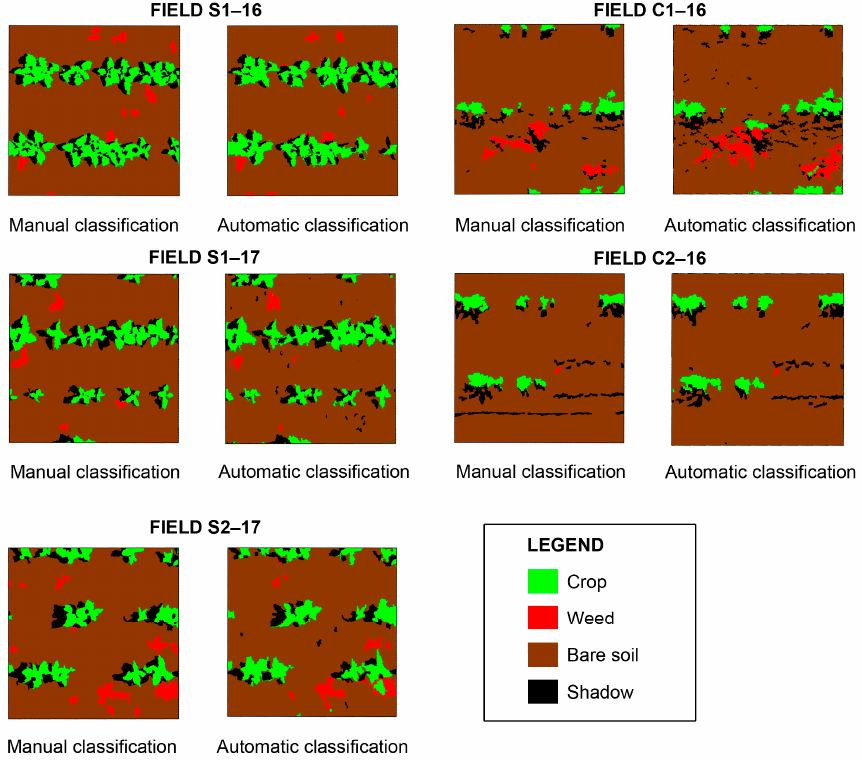
Figure 9. Examples of 2 × 2 frames validation frames, showing manual and automatic OBIA-based classification from each studied field image, taken at 30 m flight